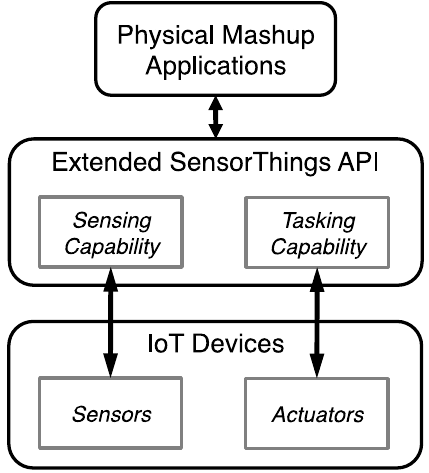
Figure 15. The high-level IoT architecture using the Extended SensorThings API.